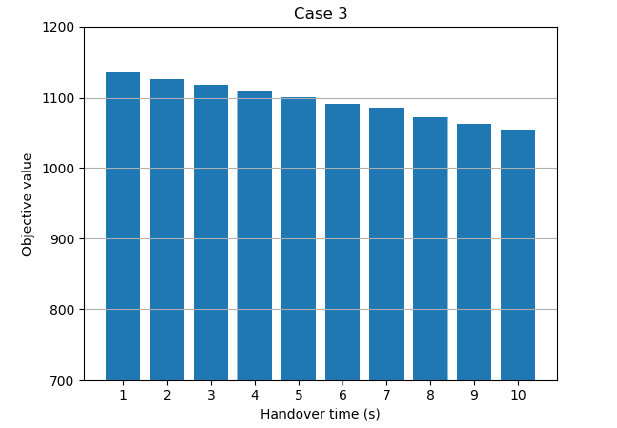
Figure 10. Objective value with respect to handover